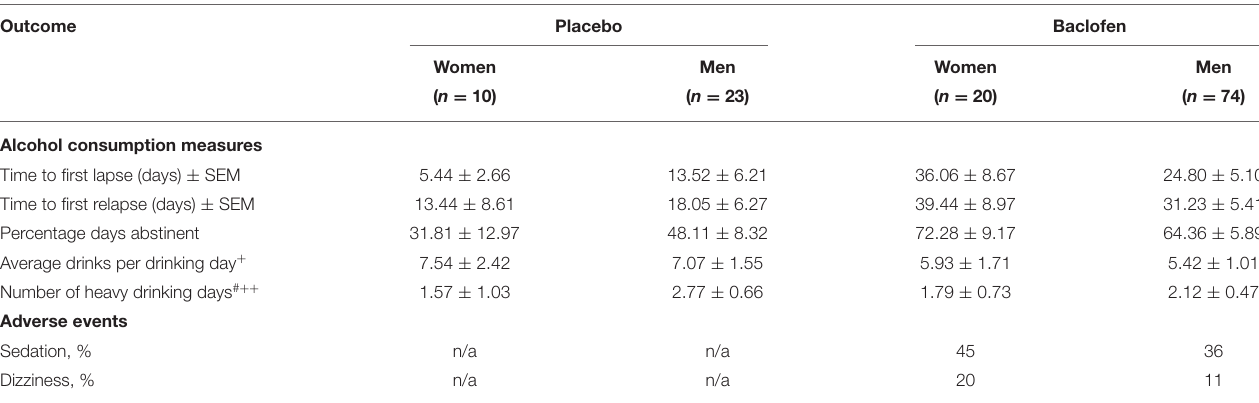
Alcohol consumption measures Time to first lapse (days) ±